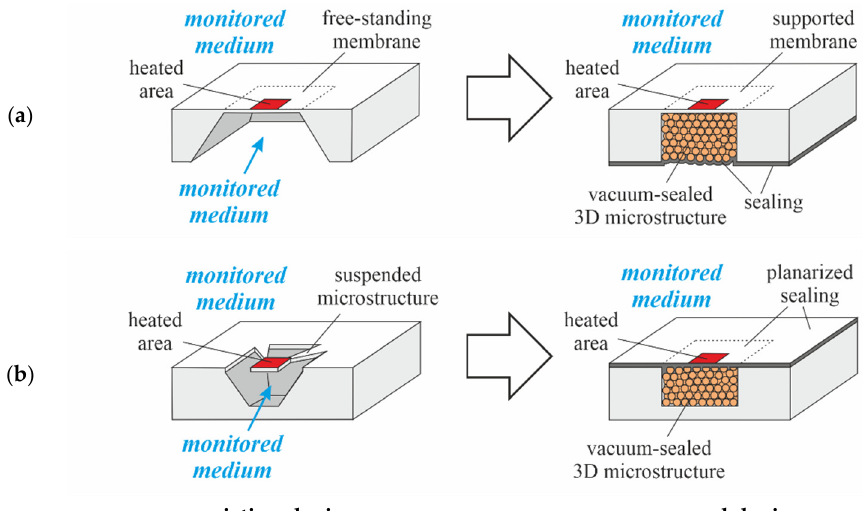
Figure 13. Modification of MEMS-based thermal sensors with a ( a ) free-standing membrane and ( b ) suspended microstructure using PowderMEMS technology. On the left side the conventional sensor design is shown (existing device), and on the right side a corresponding approach based on a vacuum-sealed 3D microstructure (proposed device) is presented.